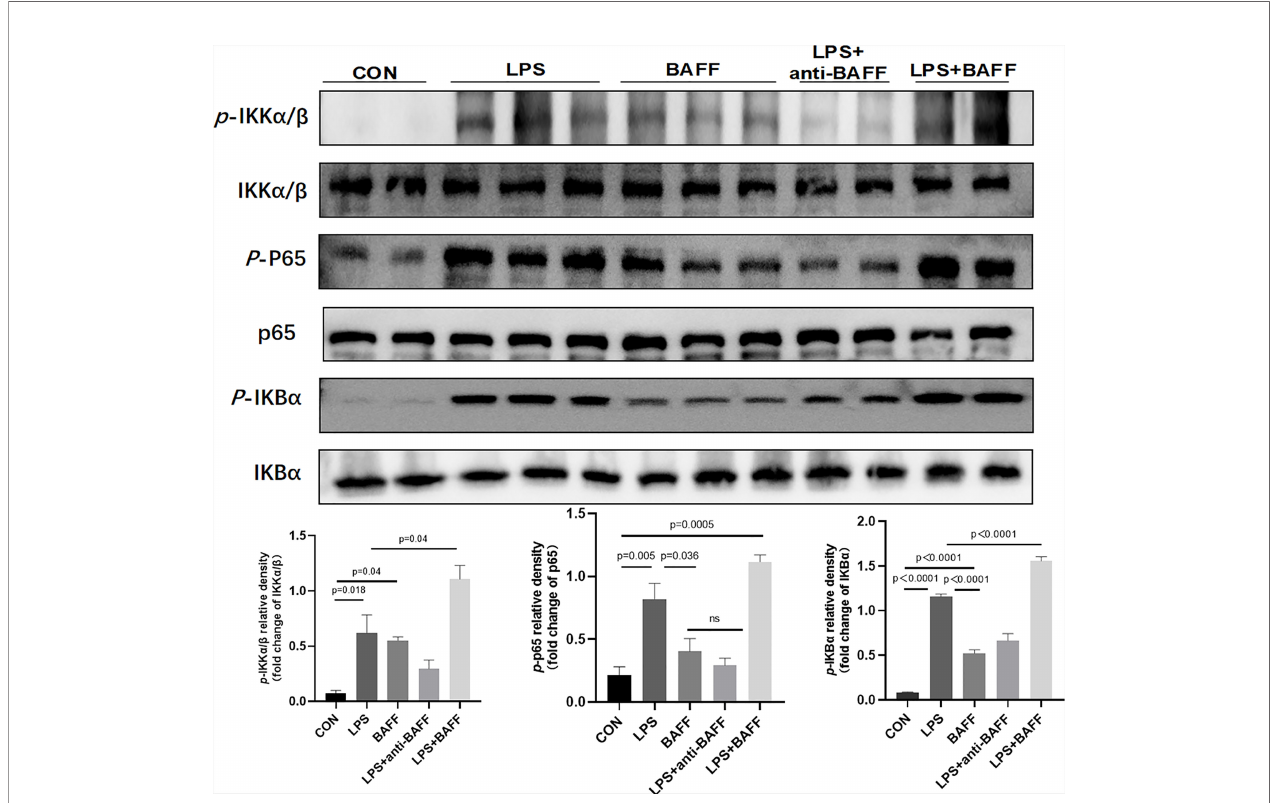
FIGURE 11 | LPS synergizes with BAFF to promote RAW264.7 cells the expression of NF- k B signal pathway. RAW264.7 cells were primed with LPS (1 ug/ml) for 6 h. Anti-BAFF antibody or mouse immunoglobulin G1 (IgG1) isotype control antibody at 1 ug/ml, recombinant mouse BAFF at 250 ng/ml in the presence of LPS 1 ug/ml for 6 h. Representative immunoblot bands for the p -IKK a / b , IKK a / b , p -p65, p65, p -IKB a , IKB a